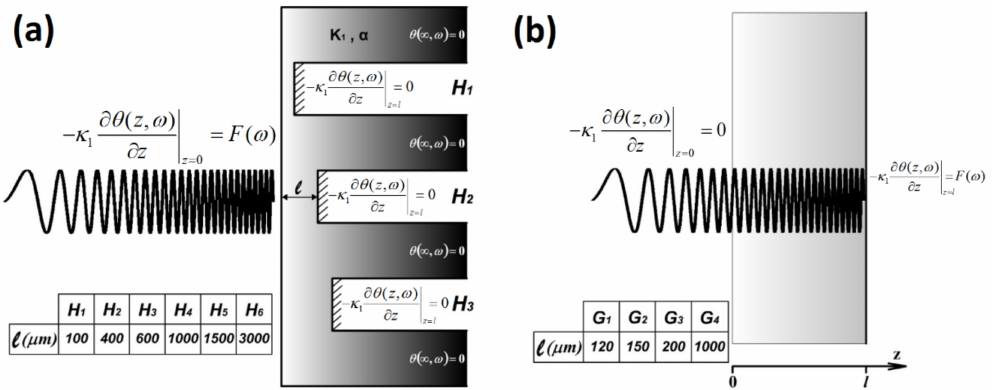
Figure 2. Schematic models of ( a ) an opaque sample with blind holes of various depths and ( b ) a turbid sample with absorber at various depths